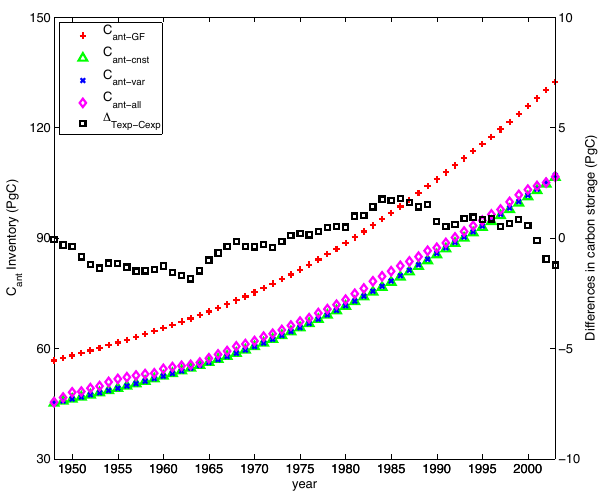
Fig. 4. Changes in the estimated ocean C ant inventories, esti- mated using the GF method and the CCSM, through time (the left axis) and the differences in total DIC inventory from two simula- tions forced with rising atmospheric CO 2 (the right axis). Shown are: C ant GF (red crosses); C ant cnst (green triangles); C ant var (blue crosses); C ant all (magenta diamonds). The black squares show the differences between total DIC in the Texp and in the